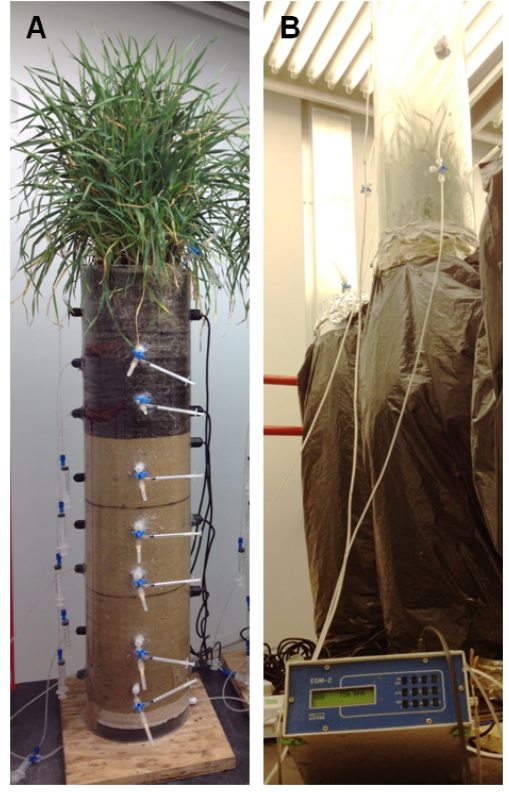
Figure 1. Mesocosm system with barley plants and sampling ports for gas and water sample collection, soil moisture and temperature measurement (a) and setup for CO 2 exchange measurements (b) . During experiments, mesocosms were shaded from light with